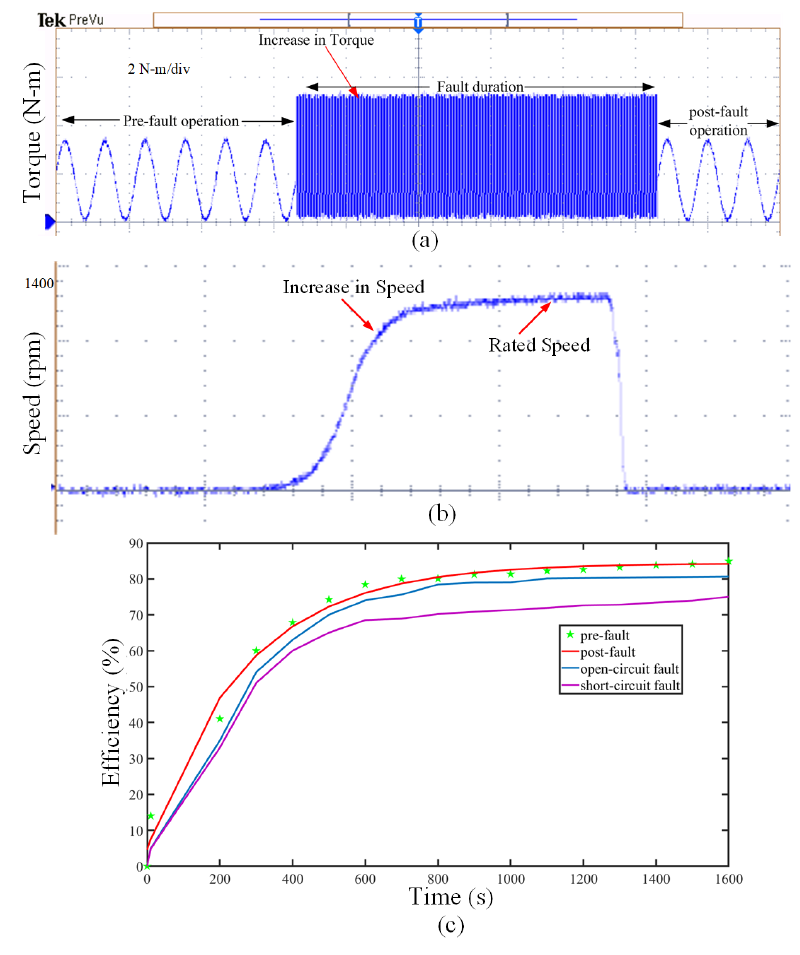
Figure 14. Motor performance under FTC operation: ( a ) Torque response, ( b ) speed response, and ( c ) efficiency